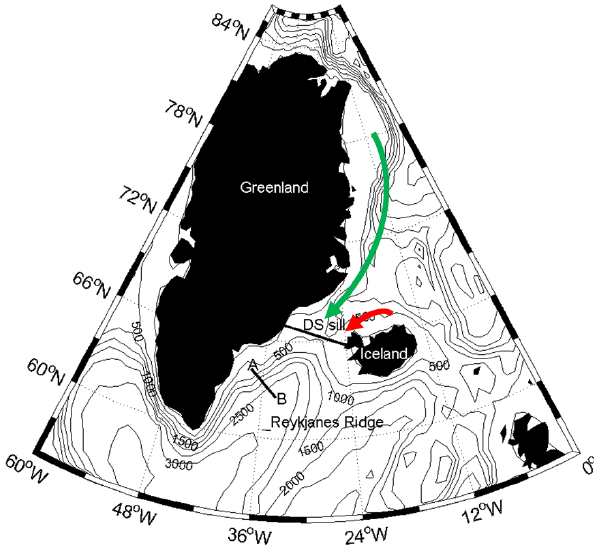
Fig. 1. Map showing the Denmark Strait overflow sill (DS sill) and the Angmagssalik mooring array (section AB). All isobaths are in metres. DSOW source pathways: EGC (green), North Icelandic Jet (red) (Jónsson and Valdimarsson, 2004).